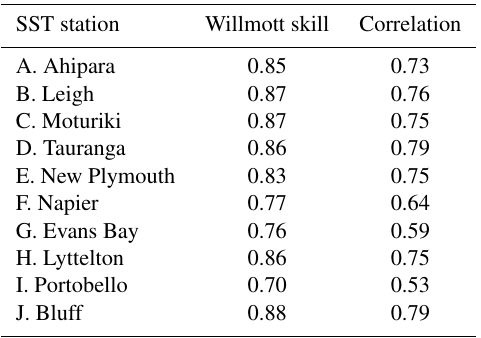
Table 7. Coastal daily surface temperature model–data comparison statistics. Willmott skill is used as the model hindcast predictabil- ity metric. Pearson correlation coefficient is used as the degree of